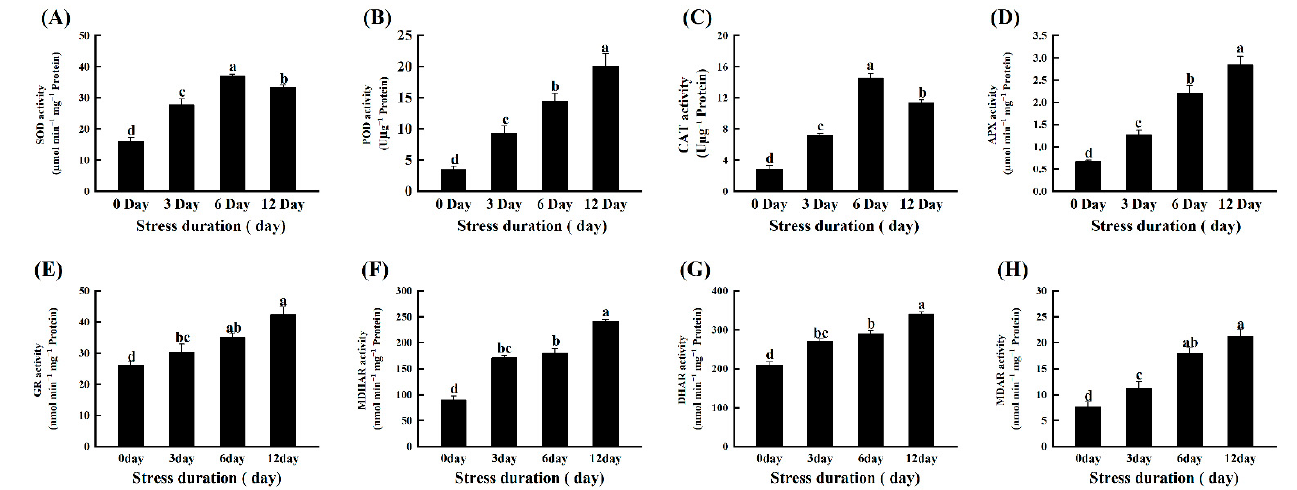
Figure 5. Effects of salt stress on antioxidant enzymes ( A ) superoxide dismutase SOD; ( B ) peroxidase POD; ( C ) catalase CAT; ( D ) ascorbate peroxidase APX; ( E ) glutathione reductase GR; ( F ) monodehy- droascorbate reductase MDHAR; ( G ) dehydroascorbate reductase DHAR; ( H ) MDAR; in tomato leaves seedlings grown for 12 days under control and salt stress. Values are mean ± SD (Standard Deviation) of three replications. Different letters indicate significant differences at p ≤ 0.05 (Tukey’s HSD test).